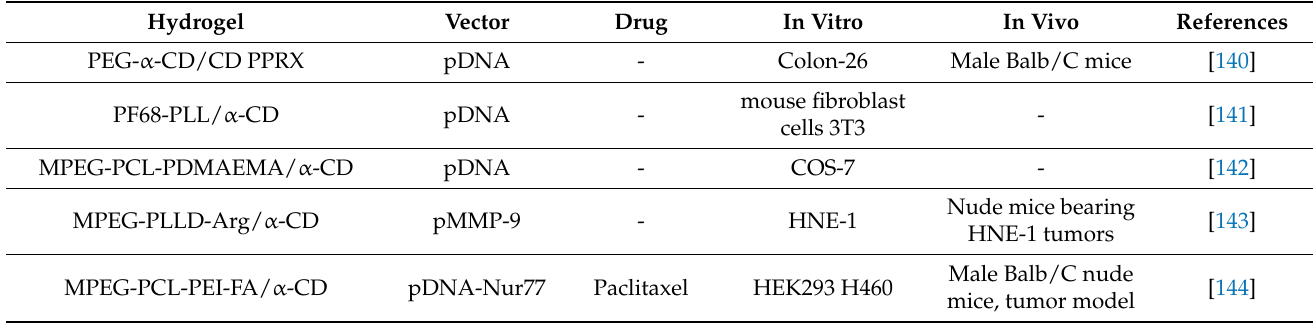
Table 3. Cyclodextrin-based supramolecular hydrogels for gene